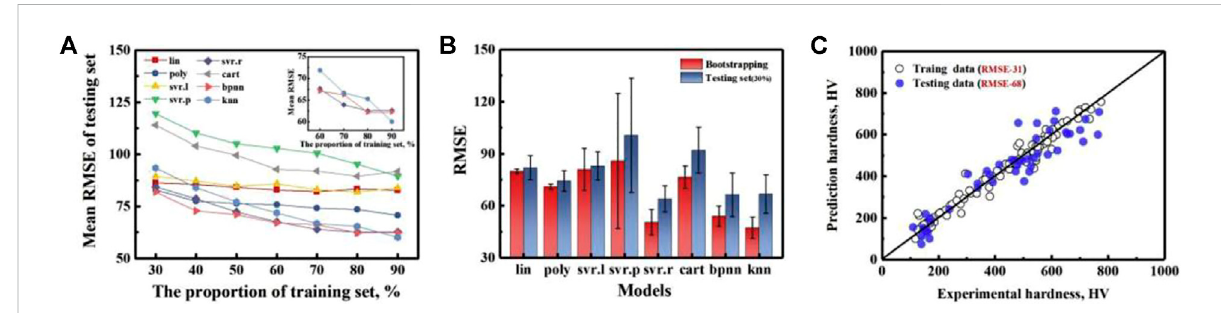
FIGURE 11 Testerrorevaluationofthreedifferentmodels, (A) aholdoutmethodand (B) bootstrappingmethods,indicatingsur.routperformsthebpnnand knnmodel. (C) Thepredictedvaluesasafunctionofthemeasuredvaluesofthesvr.rmodelfortrainingdata(randomlychosen70%)andtestingdata (the rest 30%) (Wen et al.,